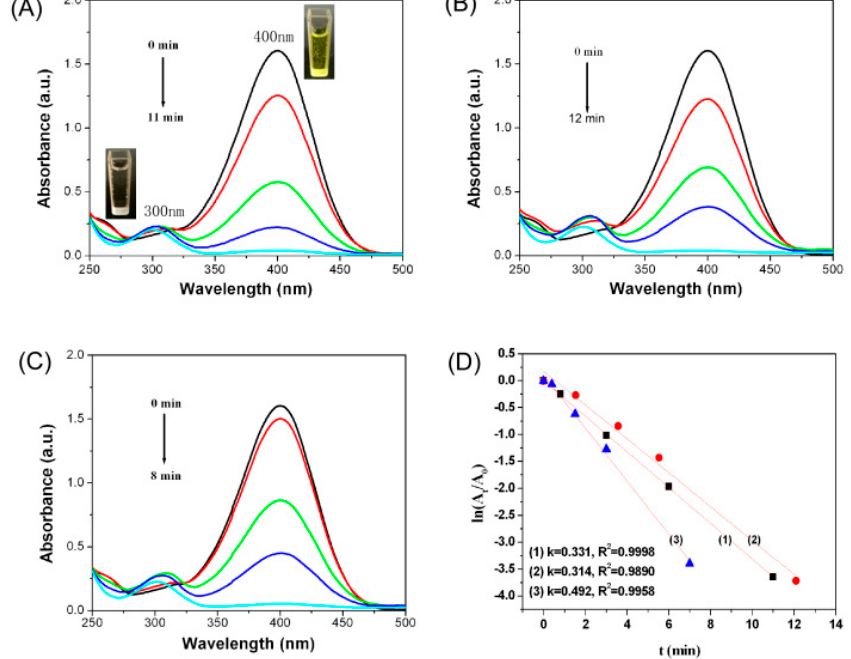
Figure 5. ( A – C ) Time-dependent absorption spectra of the reaction solution of 4-NP into 4-AP over AuNPs prepared using 0.25, 1.0, and 3.5 mM HAuCl 4 , respectively; ( D ) (1), (2), and (3) show the plot of ln(A t /A 0 ) against the reaction time over AuNPs prepared using 0.25, 1.0, and 3.5 mM HAuCl 4 , respectively.